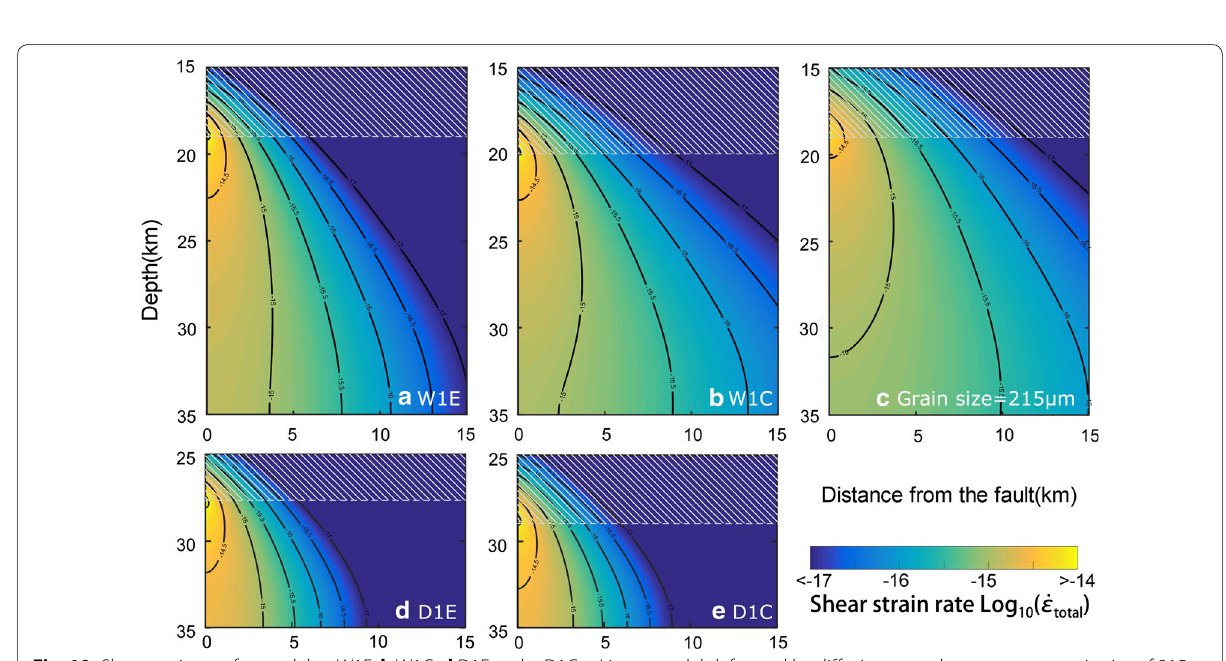
Fig. 10 Shear strain rate for models a W1E, b W1C, d D1E and e D1C. c Linear model deformed by diffusion creep has a constant grain size of 215 µ m (minimum grain size of model